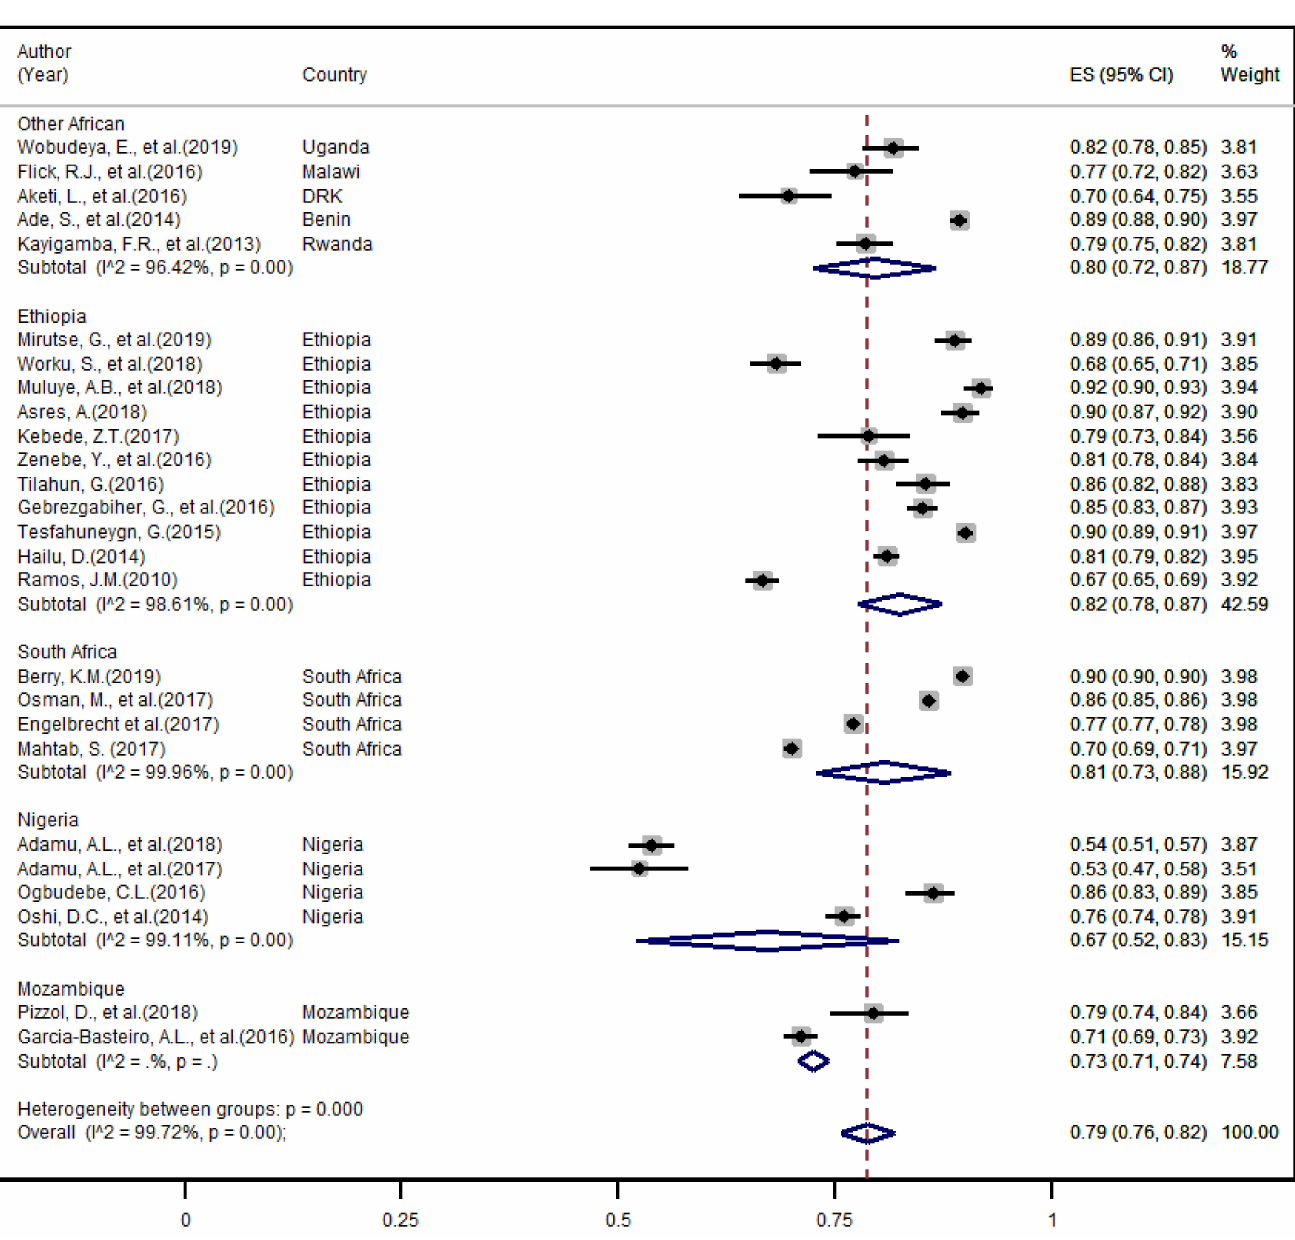
Figure 2. The overall pooled and region-based subgroup estimates of treatment success